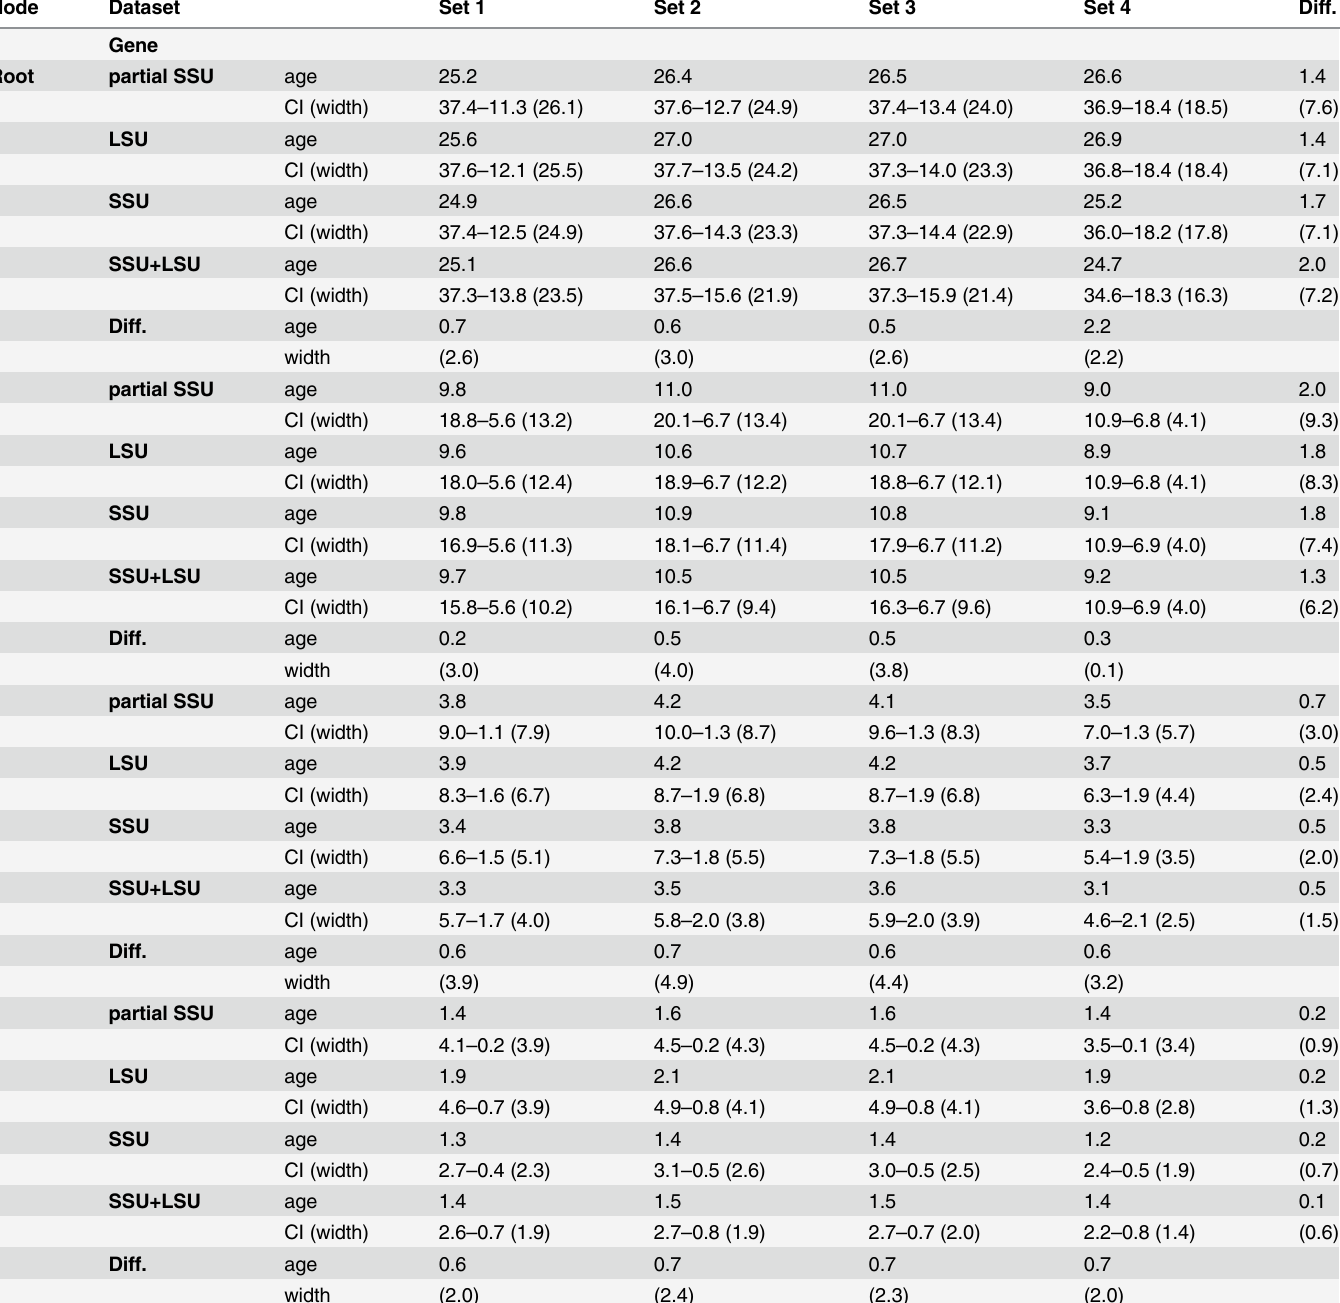
Table 3. List of divergence times estimated by using the four datasets: partial SSU, LSU, SSU, and SSU + LSU, with four different fossil calibration sets. Node Dataset Set 1 Set 2